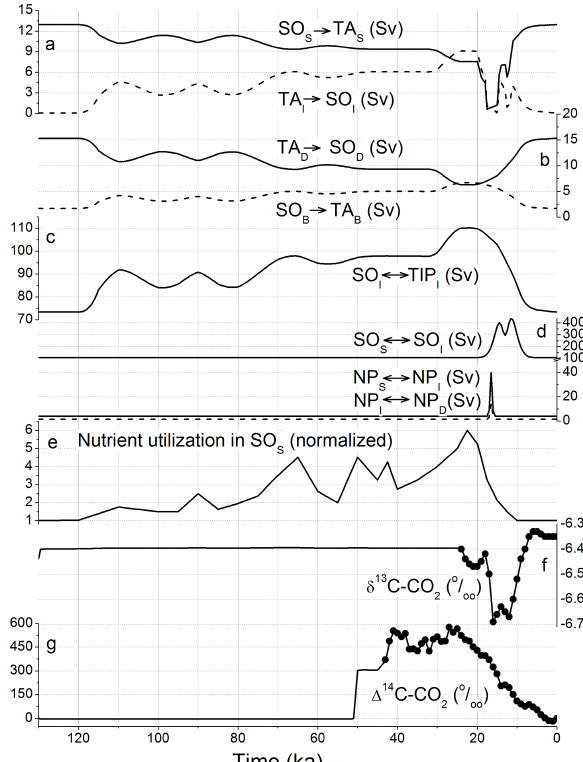
Figure 4. Model forcing applied to define ocean circulation, nutri- ent utilization in the Southern Ocean, and the isotopic composition of atmospheric CO 2 . (a–b) Net water fluxes between the South- ern Ocean (SO) and Tropical Atlantic (TA). The horizontal flows are given for (from top to bottom) surface water (subscript S), in- termediate water (subscript I), deep water (subscript D), and bottom water (subscript B); (c) horizontal exchange flux between the South- ern Ocean and Tropical Indo-Pacific intermediate waters; (d) verti- cal water exchange fluxes in the Southern Ocean and North Pacific across 100m water depth (solid lines) and 2000m water depth (bro- ken line); (e) nutrient utilization in the Southern Ocean (Martınez- Garcia et al., 2014); (f) δ 13 C value of atmospheric CO 2 . Dots indi- cate ice-core data (Schmitt et al., 2012) while the solid line defines the values applied in the model. For >24kyr BP, where data are not available, the δ 13 C-CO 2 value is set to − 6.4‰; (g) (cid:49) 14 C value of atmospheric CO 2 , dots indicate values reconstructed from the geo- logical record (Reimer et al., 2013) while the solid line defines the values applied in the model. For >50kyr BP, where data are not available, the atmospheric (cid:49) 14 C-CO 2 is assumed to correspond to the pre-anthropogenic modern value